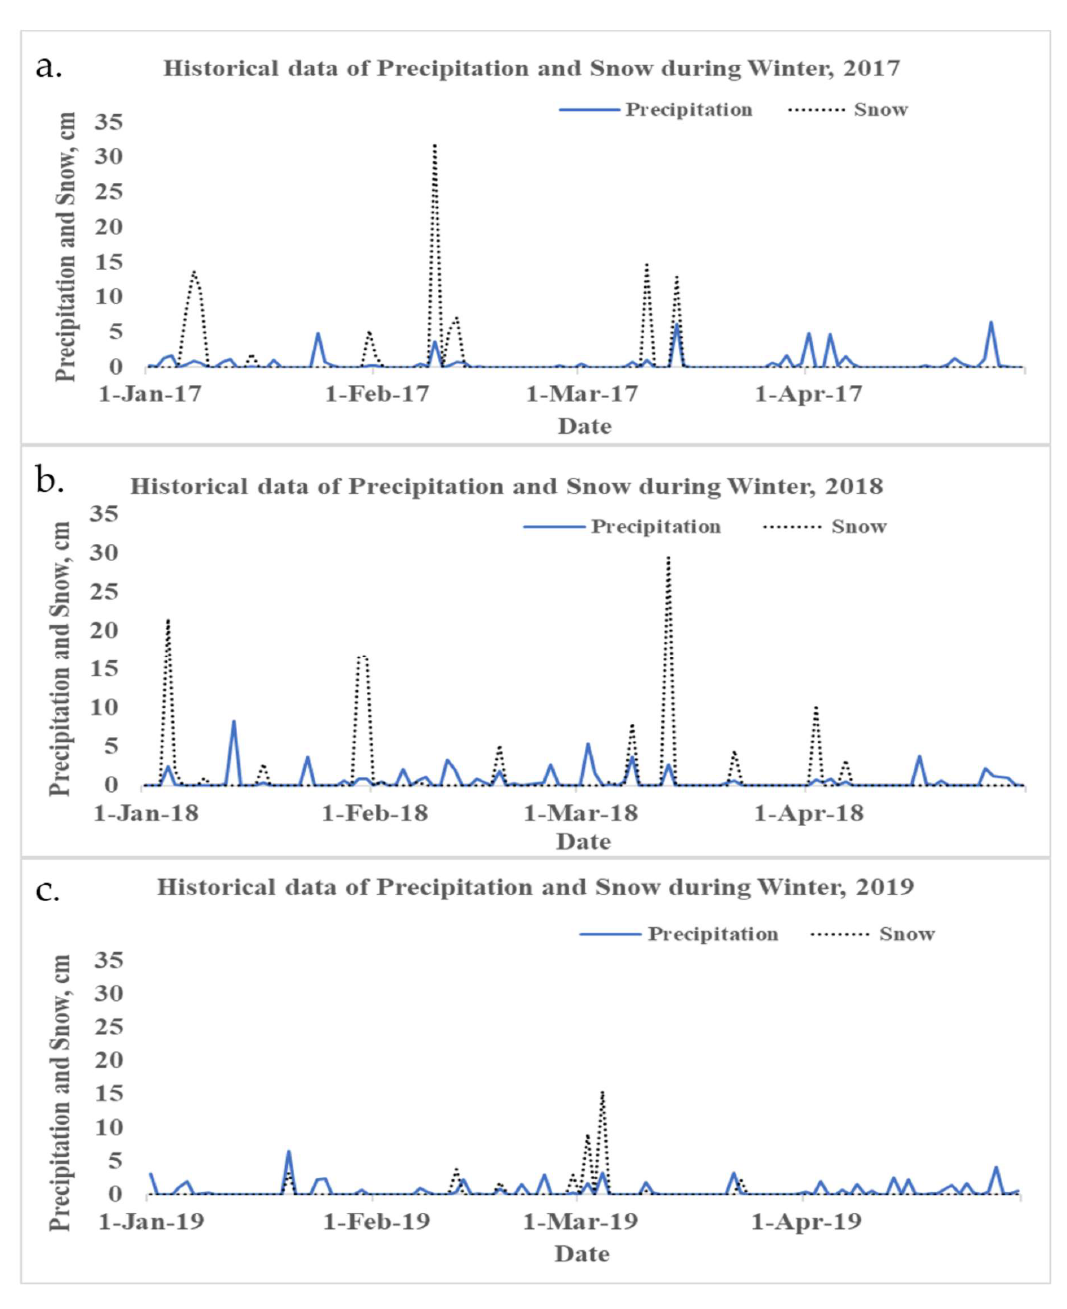
Figure 8. Precipitation and snow events ( a ) 2017, ( b ) 2018, and ( c ) 2019 in South Kingstown, RI. ( a ) total four significant snow events (>10 cm) and low to moderate precipitation events appeared during winter in 2017; ( b ) three significant snow (>10 cm) events (among them one was the worst >25 cm) and low to moderate with high frequency precipitation occurred during winter in 2018; and ( c ) only one significant snow and low to moderate precipitation happened during the winter in 2019.